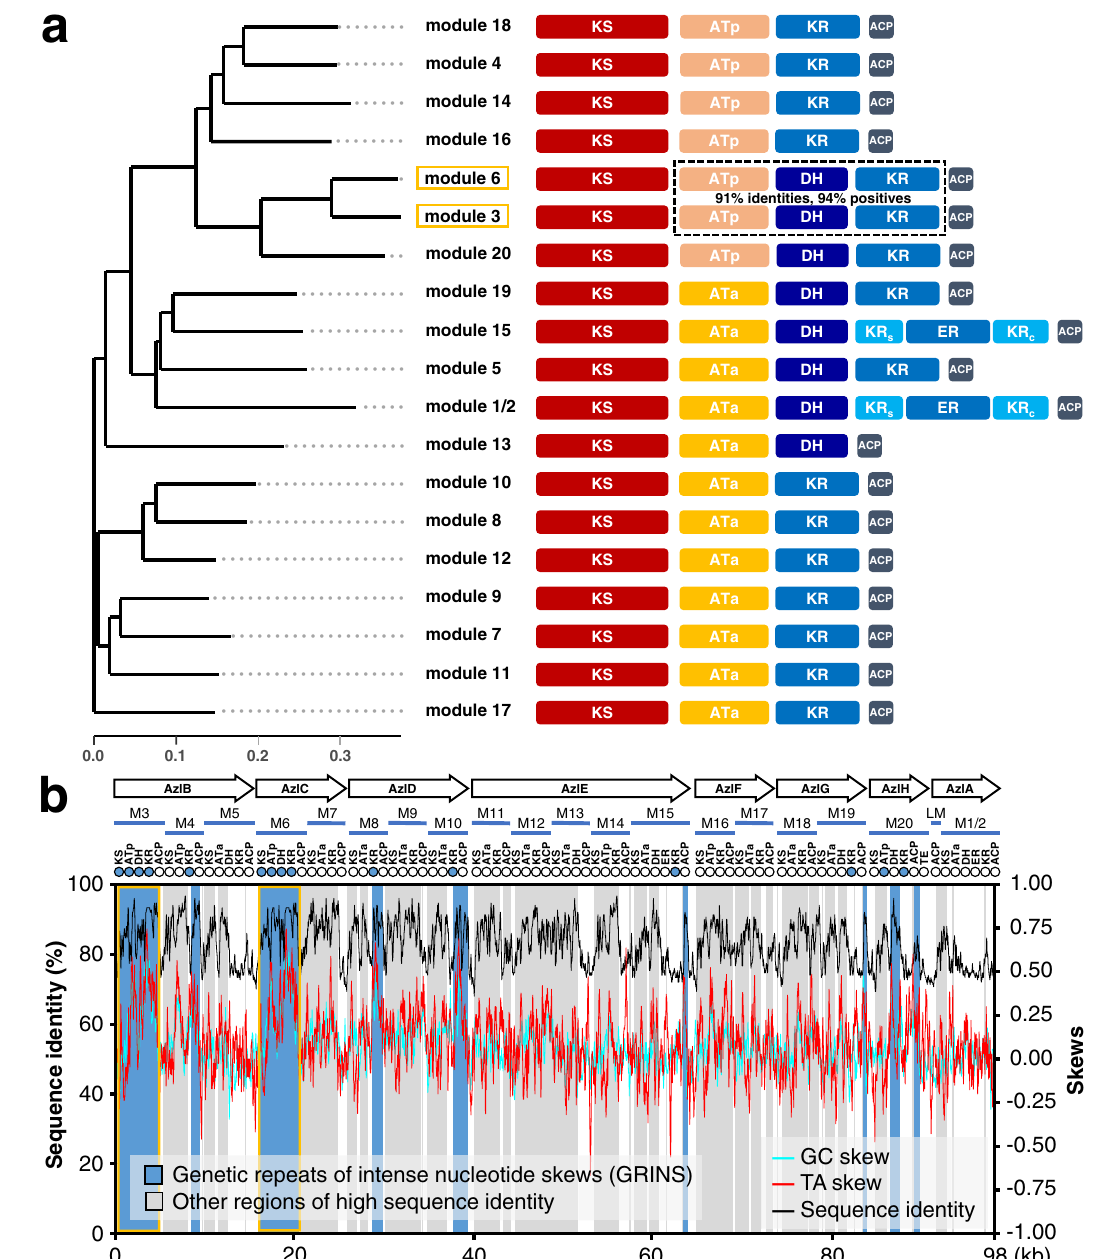
Fig. 3 | Phylogenetic and genetic repeats of intense nucleotide skew (GRINS) analysis of AZL PKS. a Phylogenetic analysis of AZL PKS modules. Each bar representsadomaininPKS,withATathedomainthatloadsamalonyl-CoAtobuild an acetate unit and ATp the domain that loads a methylmalonyl-CoA to build a propionate unit. The numbers in the dotted frame show identities and positives of the ATp-DH-ER tridomain between modules 3 and 6. b GRINS in AZL PKS.